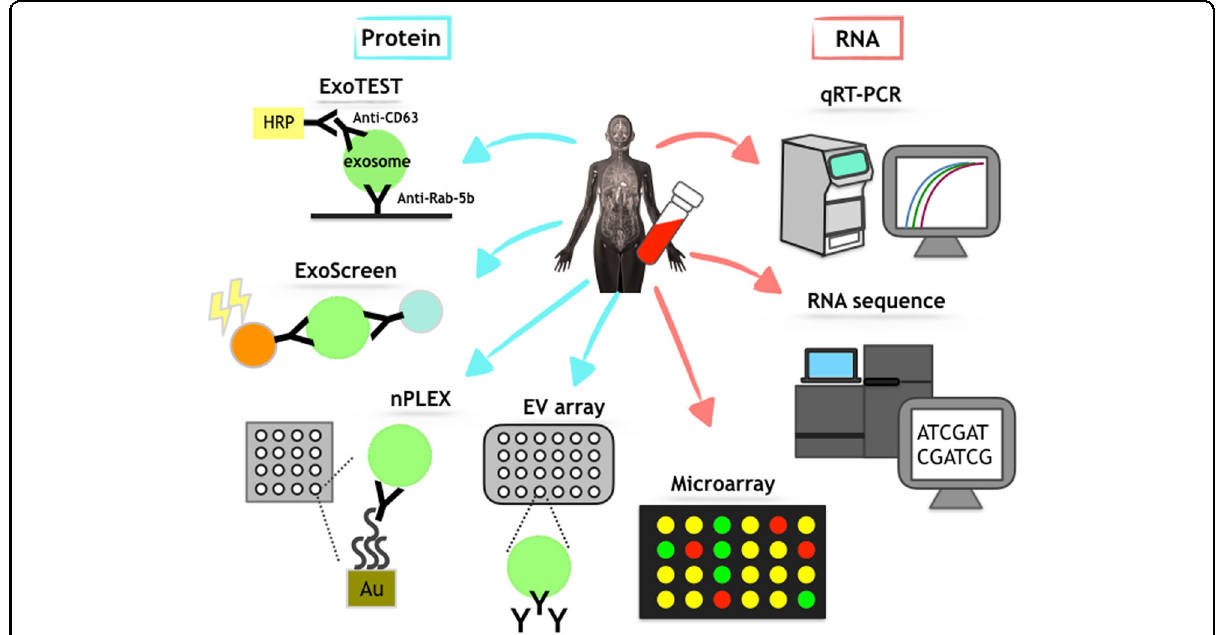
Fig. 3 Various types of secreted miRNAs from cells. Several types of circulating miRNAs can be found in human body fl